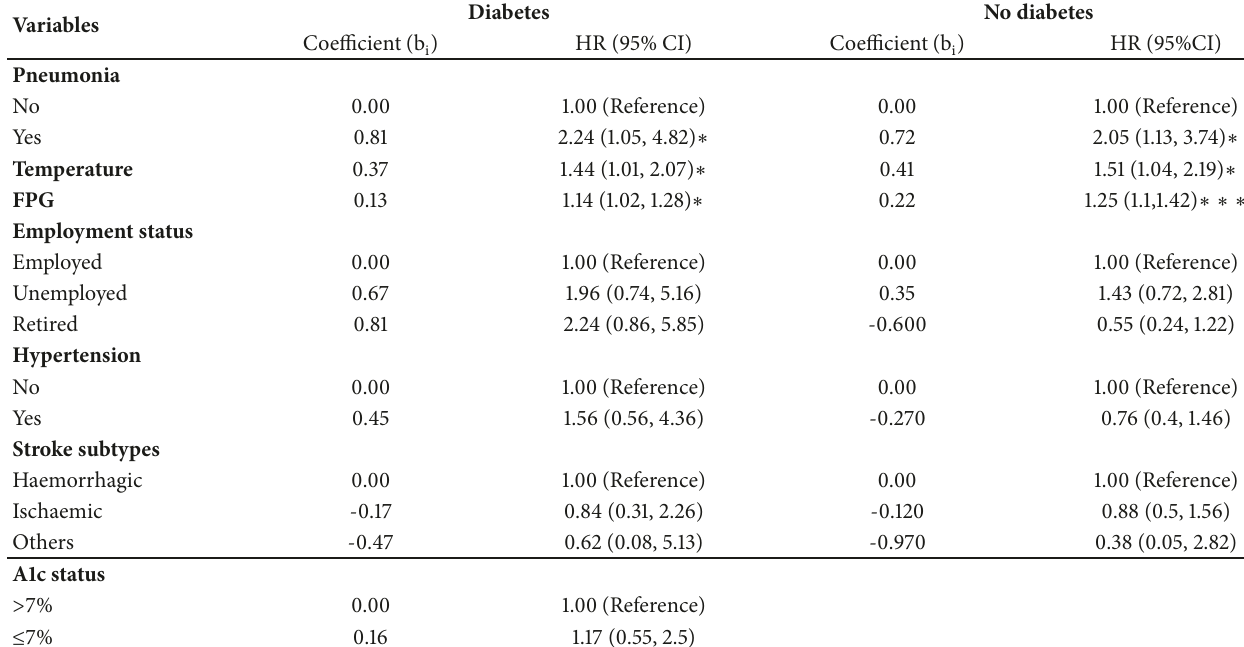
Table 6: Determinants of survival of stroke patients with and without